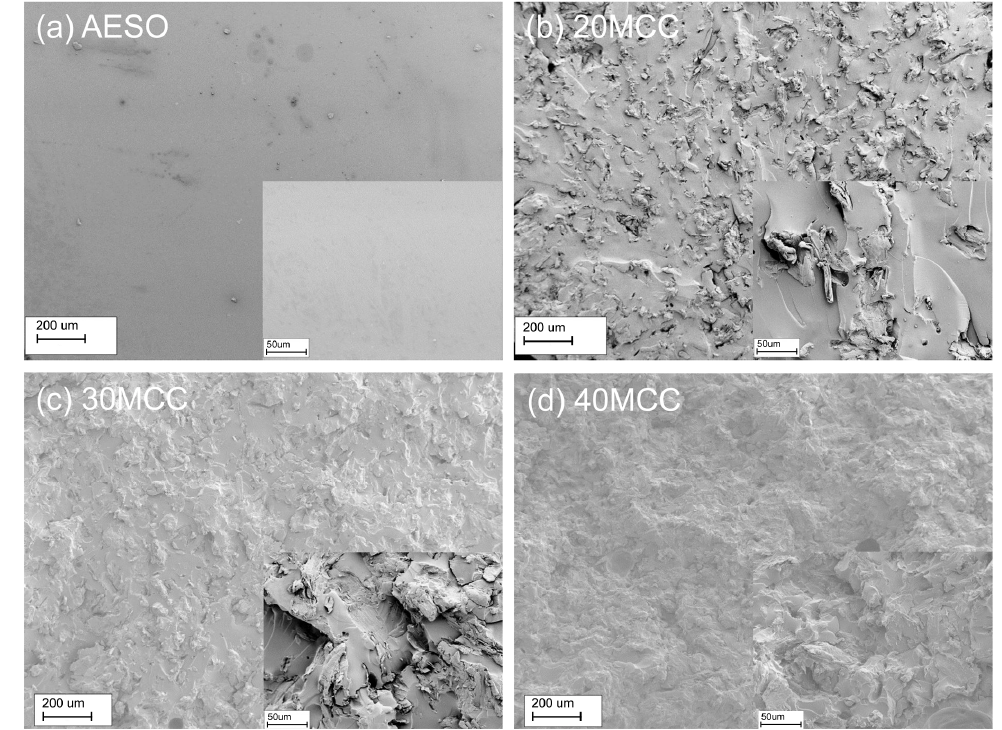
Figure 7. Scanning electron microscope (SEM) images of pure AESO and MCC/AESO composites with different MCC loadings .